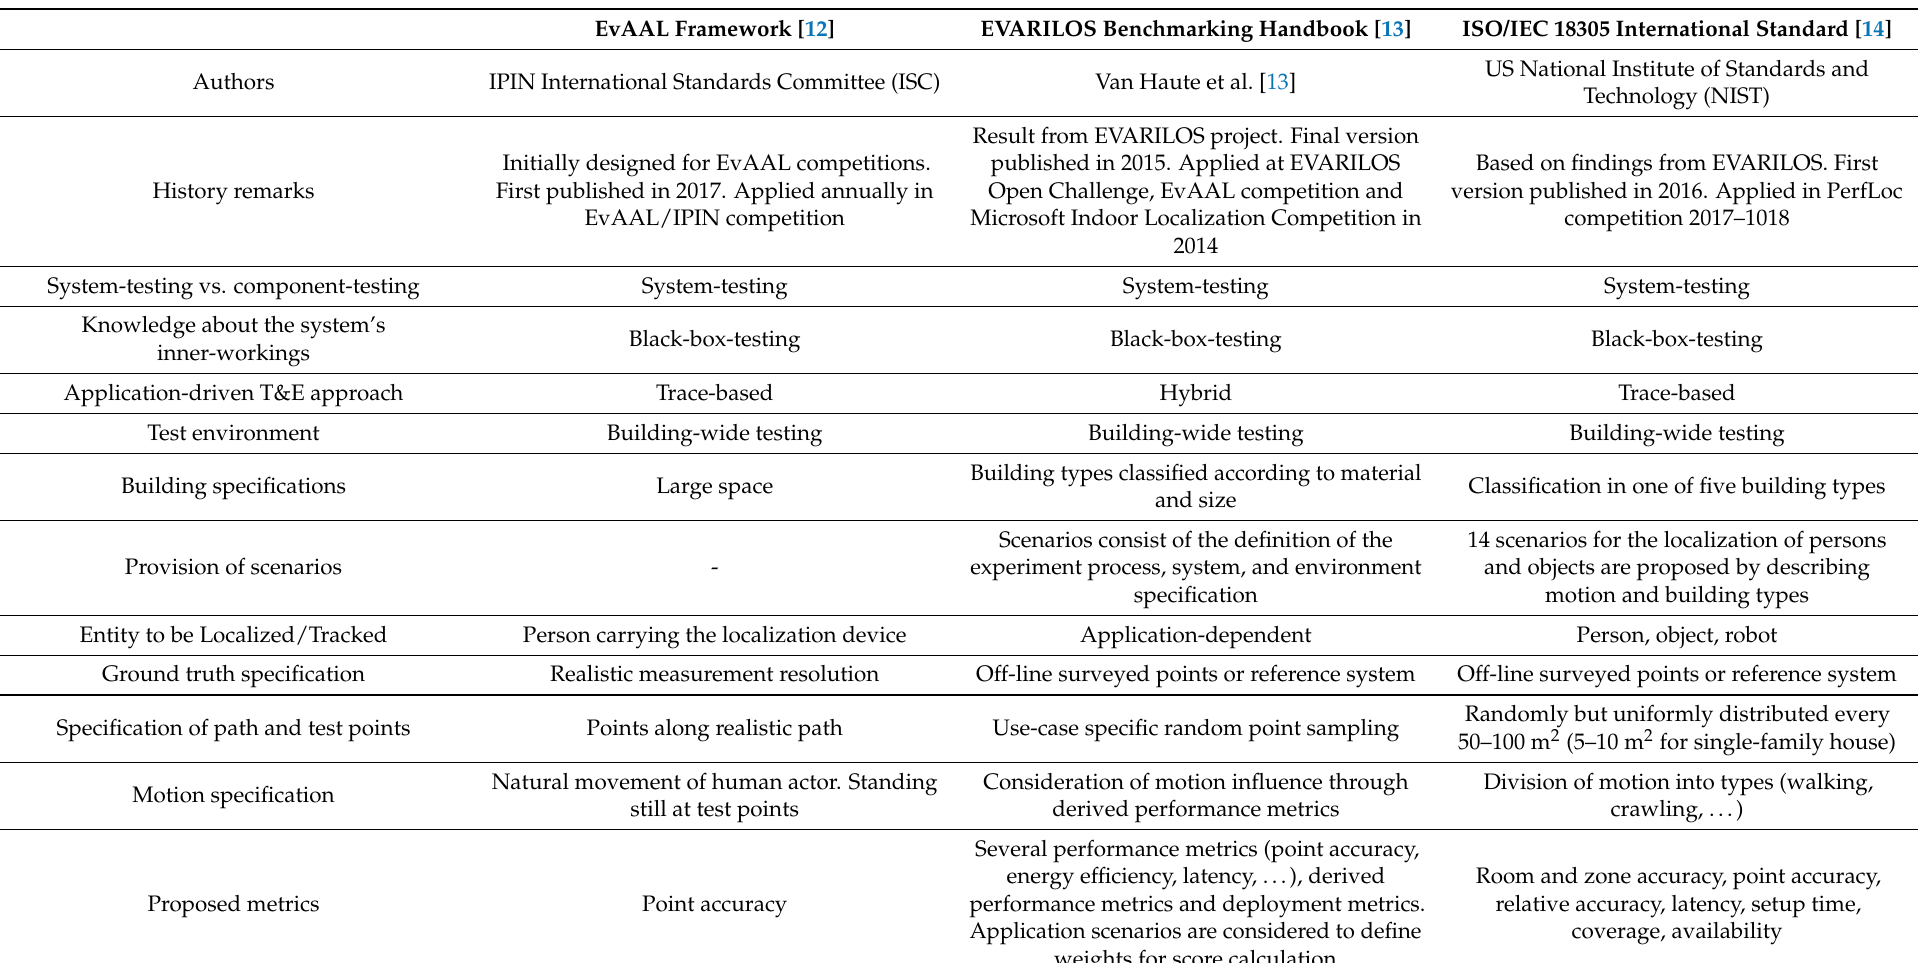
Table 1. Comparisons of methodologies for test and evaluation of indoor localization